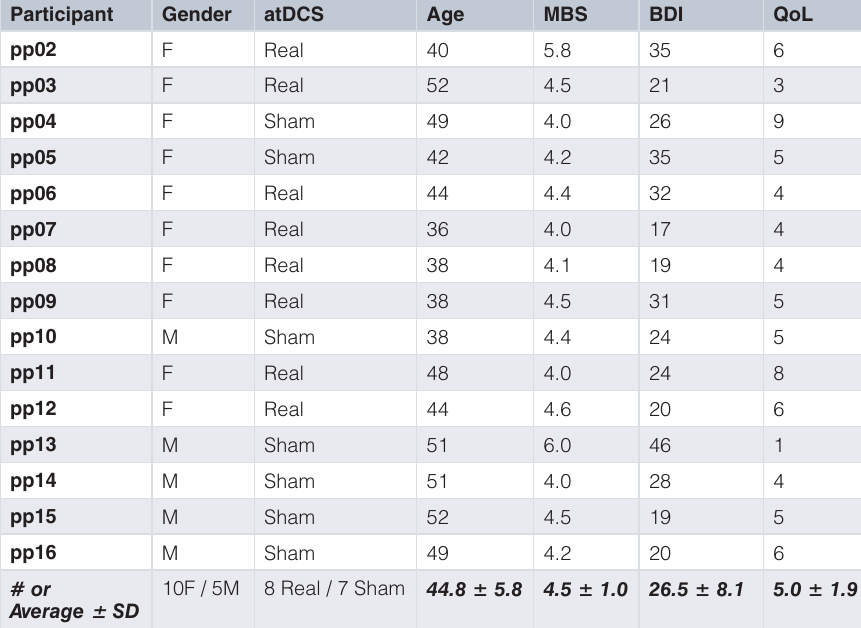
Table 2A. Demographic characteristics of the patients. Participant Gender atDCS